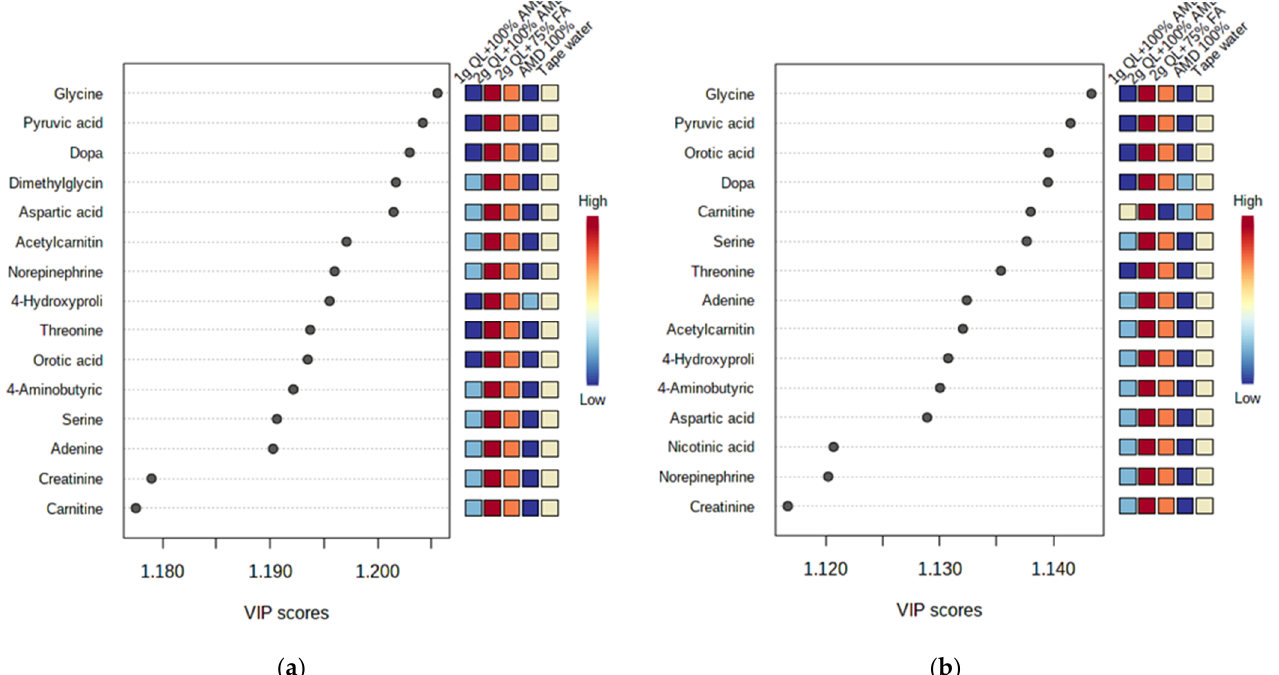
Figure 3. Discriminant metabolites identified by PLS-DA ranked by variable importance in projection (VIP) scores in component 1. The relative abundance of each metabolite from Marykies ( a ) and Royal ( b ) cultivars are indicated with a color code scaled from blue (low) to red (high). Tap water (T1); AMD 100% (T2); 1 g QL + 100% (T3); 2 g QL + 100% AMD (T4) and 2 g QL + 75% FA (T5), respectively.